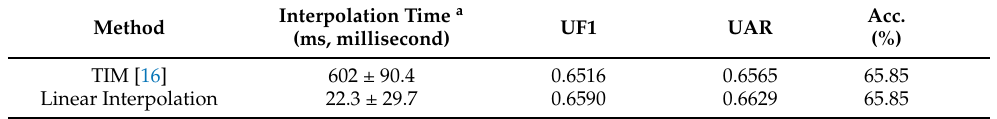
Table 1. TIM vs. linear interpolation using Early Fusion Video Transformer.